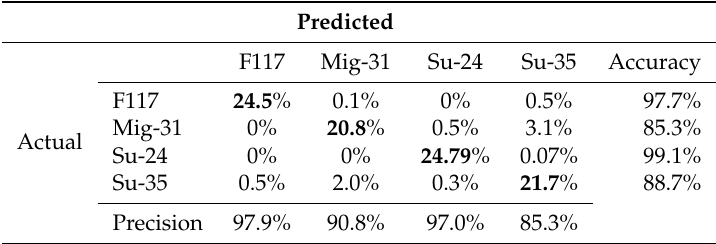
Table 4. Confusion matrix for mean performance of the per-frame ELM classifier on the 4-class plane dropping results. Results have been averaged over 20